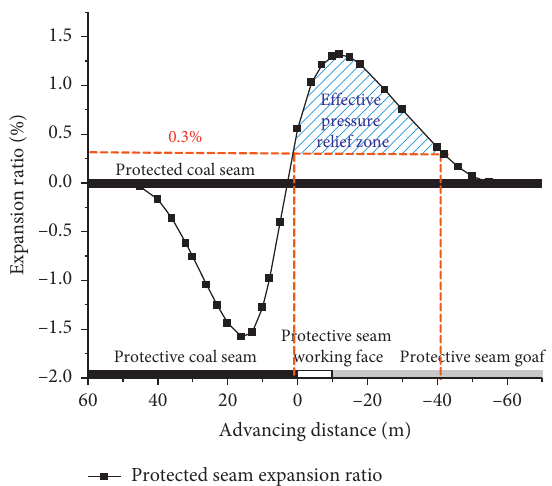
Figure 13: Change curve of expansion rate of protected